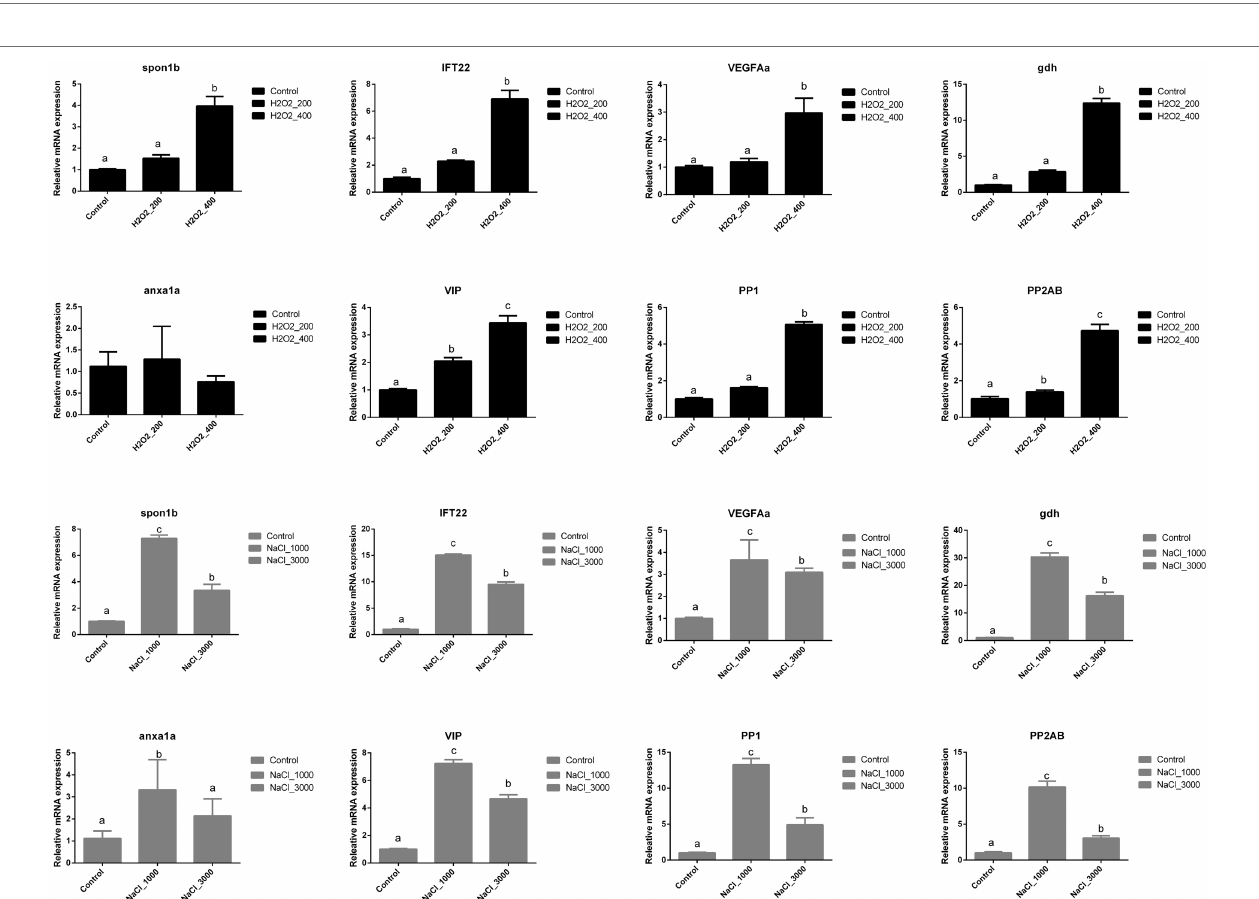
FIGURE 1 | Effects of H 2 O 2 (200, 400 mg/ml) and NaCl (1,000, 3,000 mg/ml) pre-treatment during egg hatching on the hatchability, fry mortality, egg mortality including fungi-induced mortality and other factor-induced mortality of loach.